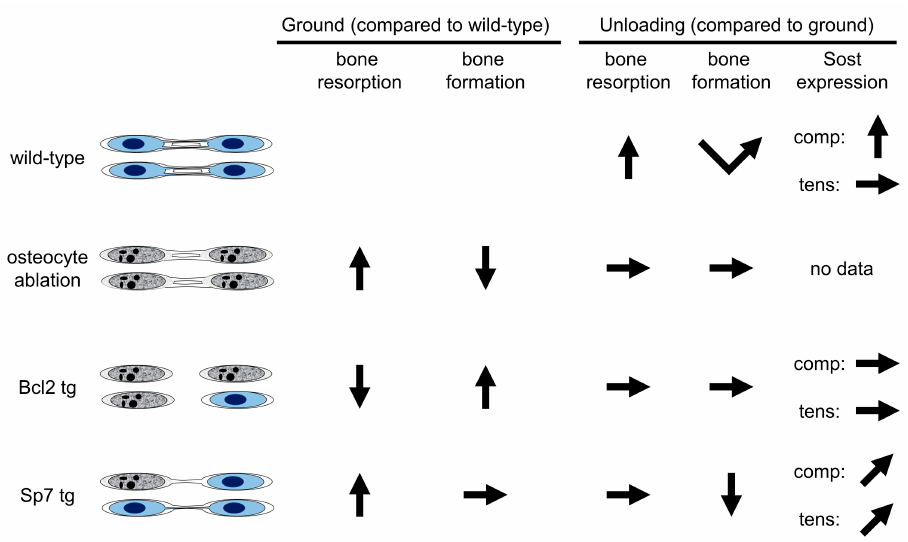
Figure 4. Summary of the three mouse models. The left columns show the changes in the grounded (physiological) condition compared to wild-type mice, and the right columns show the changes in the unloaded condition compared to the grounded condition. Unloading (tail suspension) experiments were performed for two weeks in wild-type, Bcl2 tg and Sp7 tg mice, and for one week in osteocyte-ablated mice [13,20,35]. In unloading of wild-type mice, bone resorption is increased and bone formation is reduced in the first week but it recovers in the second week. In osteocyte-ablated mice, bone resorption is increased and bone formation is reduced in the grounded condition due to osteocyte death, and the changes are not further altered in the unloaded condition. In Bcl2 tg mice, bone resorption is reduced and bone formation is increased in the grounded condition due to the completely interrupted lacunocanalicular network, and the changes are not further altered in the unloaded condition. Although bone resorption is increased due to osteocyte death, bone formation is normal in Sp7 tg mice in the grounded condition. Although the increased bone resorption is not further altered by unloading in Sp7 tg mice, bone formation is reduced and it never recovers during unloading. In immunohistochemical analysis, Sost expression in osteocytes is increased in wild-type mice by unloading in the compression (comp) side but not in the tension (tens) side, whereas it is unchanged and marginally increased in Bcl2 tg and Sp7 tg mice, respectively, by unloading in both sides.